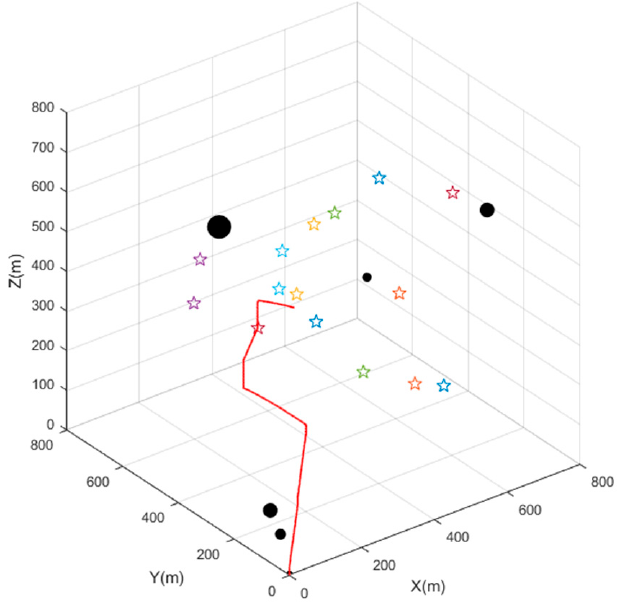
Figure 11. Search trajectory map (coordinates (192.7, 244.5, 496.7)). The AUV uses a target search algorithm based on the perception map to continuously determine the search location decision, and approaches the suspected target point when a suspected target appears within the sonar detection range until all the targets are searched. The final search trajectory diagram is shown in Figure